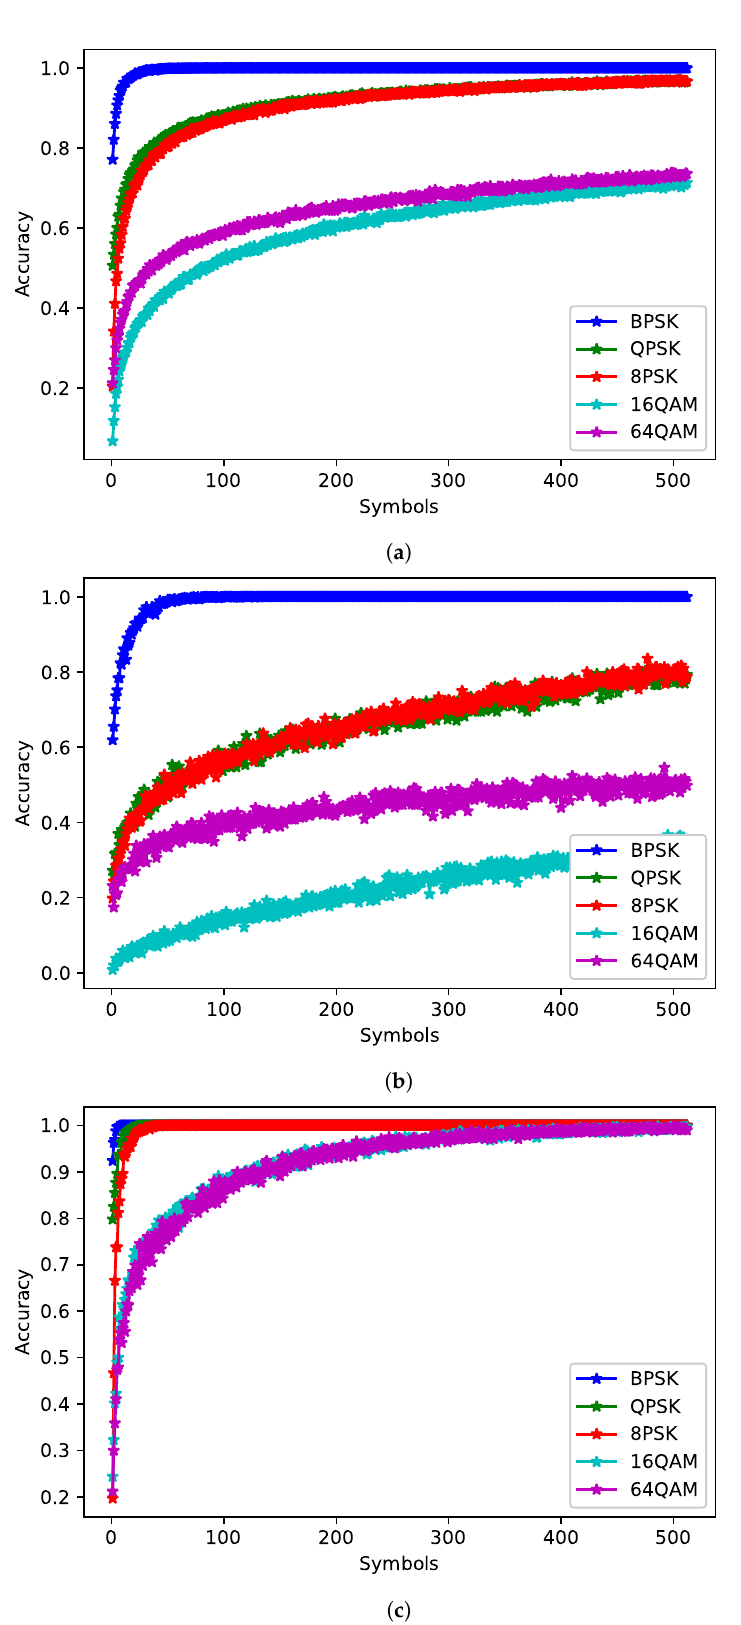
Figure 8. The ML estimate of the posterior probabilities ( a ) averaged from 0 to 10 dB ( b ) at 0 dB and ( c ) at 10